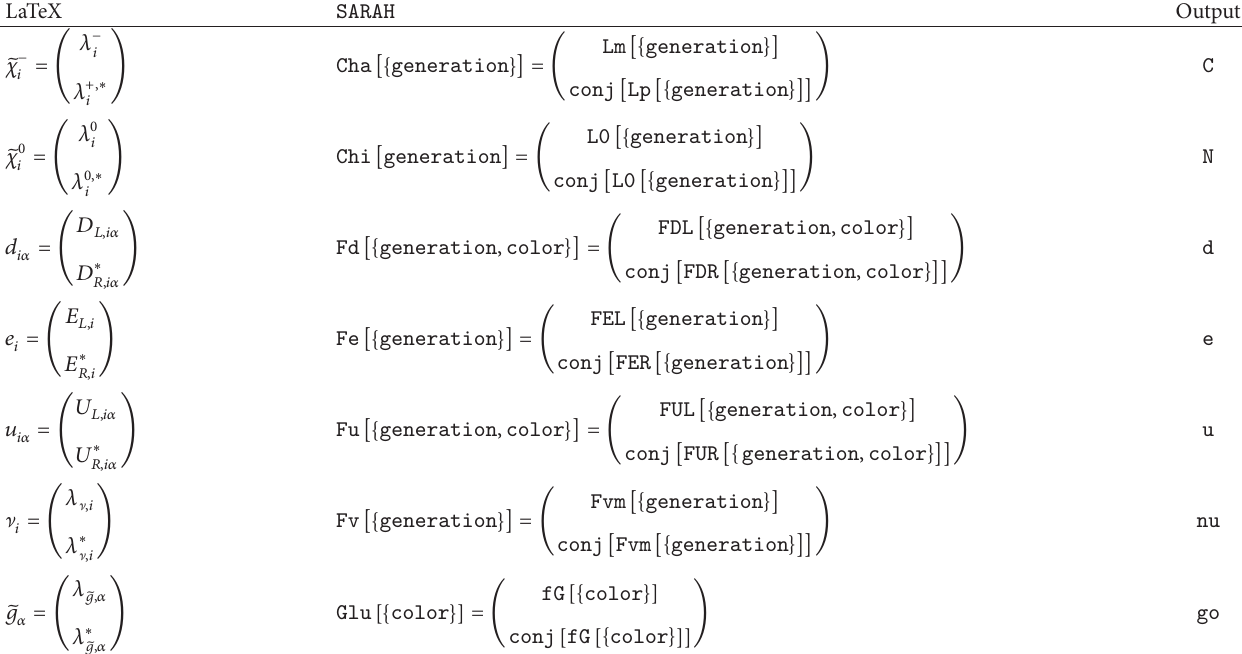
Table 2: Fermions in the B-L- SSM after electroweak symmetry breaking.